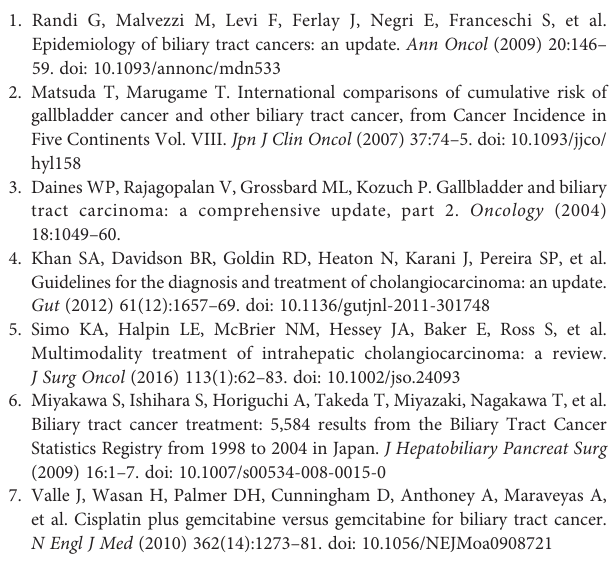
SUPPLEMENTARY FIGURE 1 | The median OS of GBC and BDC. Kaplan- Meierestimates ofthemOSofGBCandBDC.ThemOSofGBCwas535days,and that of BDC was 438 days, showing a slightly better tendency with GBC SUPPLEMENTARY FIGURE 2 | The median PFS of GBC and BDC. Kaplan- Meier estimates of the mPFS of GBC and BDC. The mPFS of GBC was 460 days, and that of BDC was 411